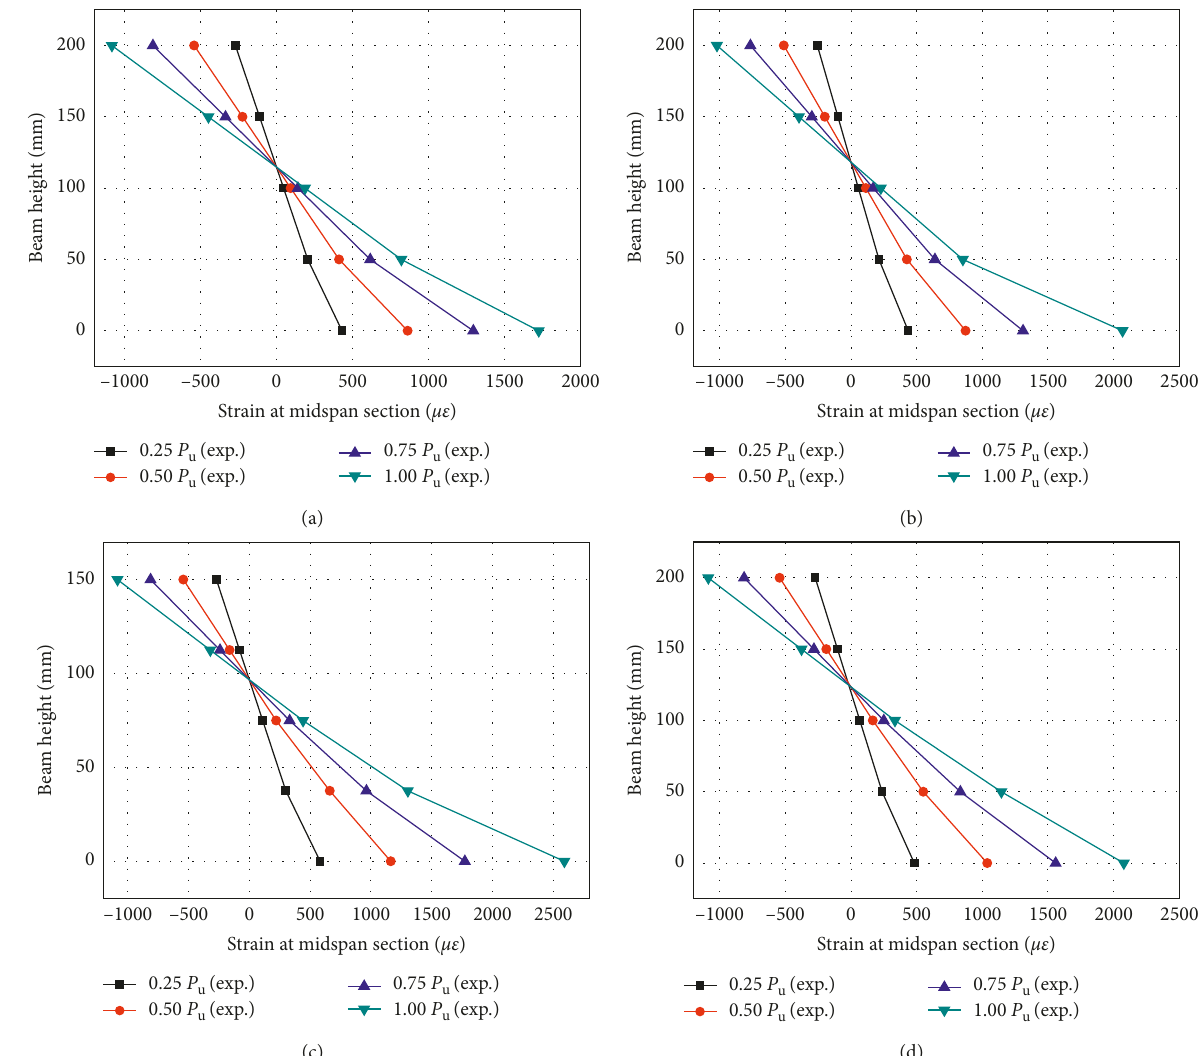
Figure 9: Strain distribution at the midspan cross section: (a) specimen GC-1; (b) specimen GC-2; (c) specimen GC-3; (d) specimen